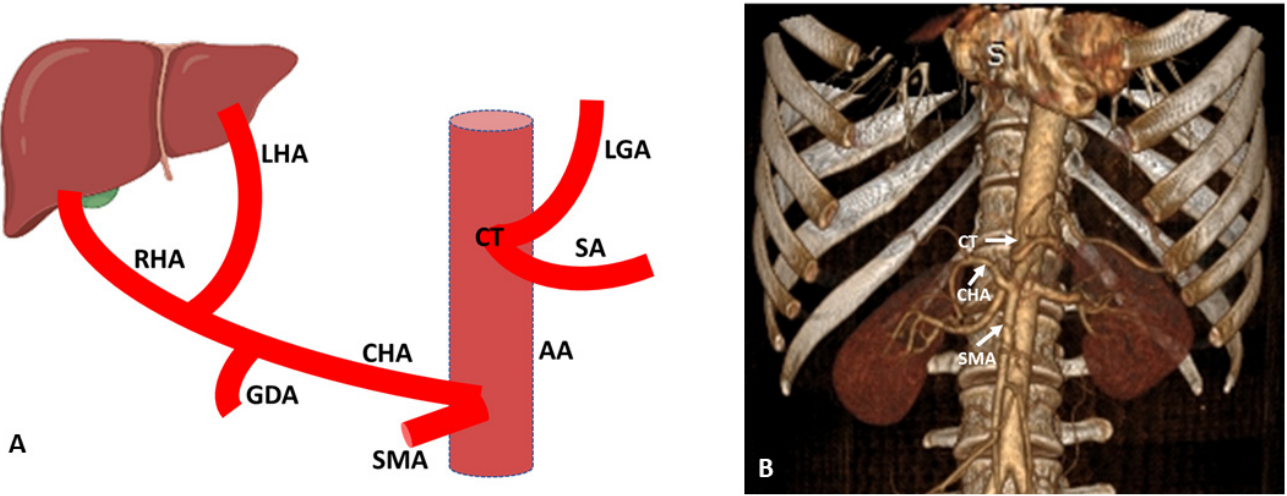
Figure 3. ( A ) Schematic representation of aberrant (replaced) CHA originating from SMA. ( B ) Three- dimensional (3D) volume render (3D-VR) image (64-row scanner CT angiography) of the abdominal region showing the aberrant (replaced) CHA originating from SMA. AA: Abdominal aorta; CT: Celiac trunk; SA: Splenic artery; LGA: Left gastric artery; CHA: Common hepatic artery; RHA: Right hepatic artery; LHA: Left hepatic artery; GDA: Gastroduodenal artery; SMA: Superior mesenteric artery.